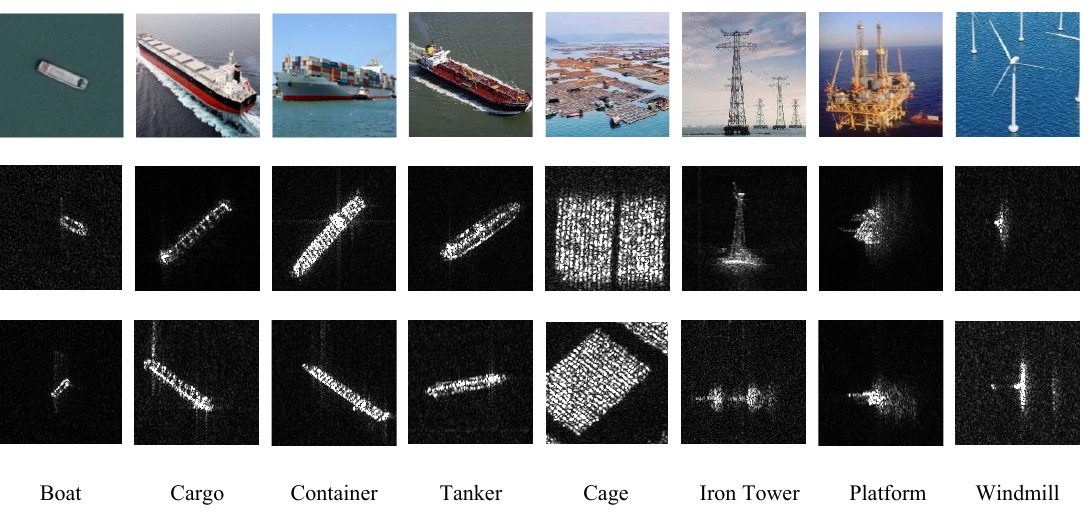
Figure 1. Samples of different maritime targets in optical and SAR images.